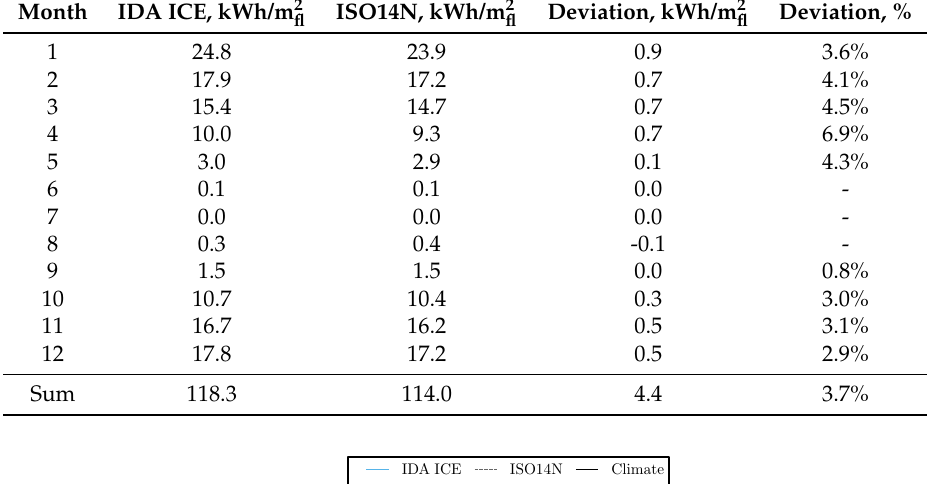
Table A3. Energy use for space heating as monthly sums and deviations between the models.